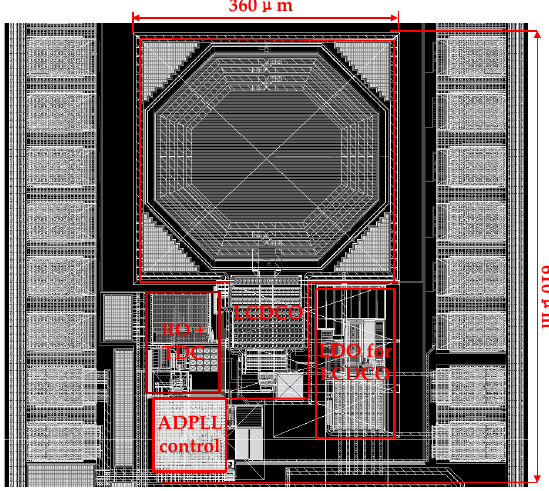
Figure 14. Layout photograph of the ADPLL